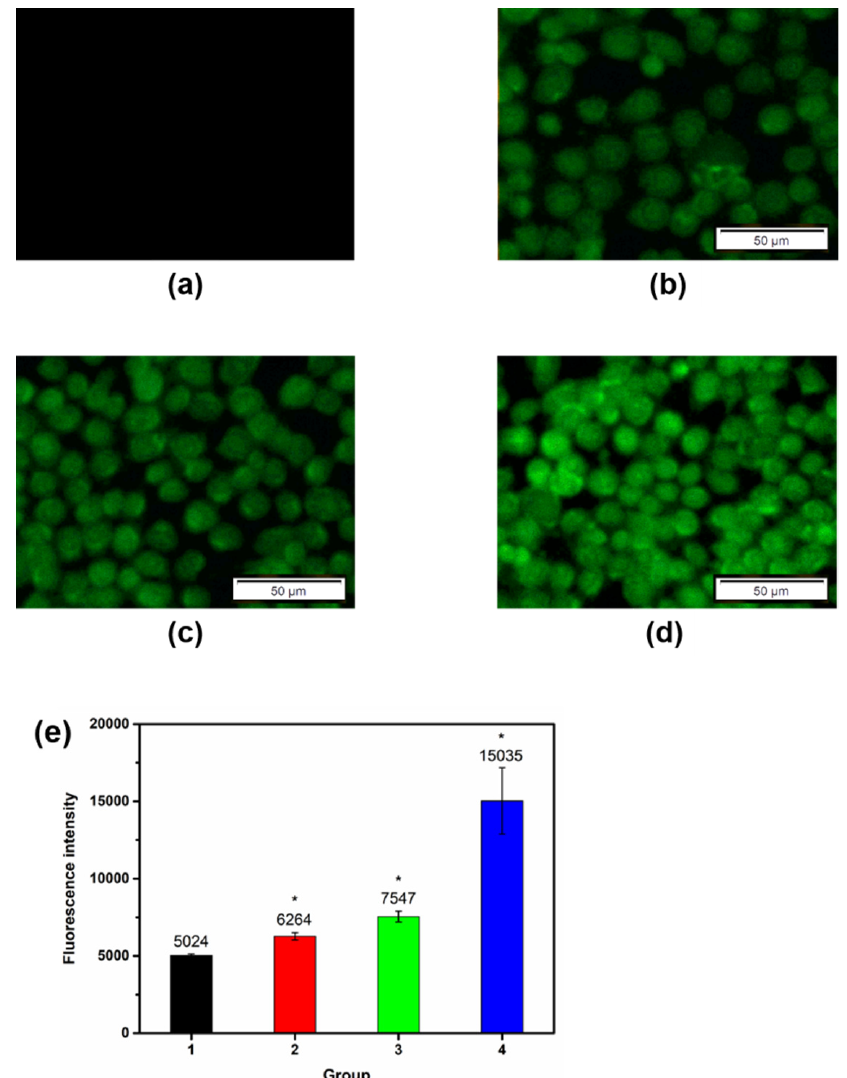
Figure 5. Detection of ROS using DCFDA assay on 4T1 cells for ( a ) control; ( b ) PA-AgNPs without Dox; ( c ) Dox-carried PA without AgNPs; ( d ) Dox-carried PA-AgNPs; and ( e ) fluorescence intensity of each group (Group 1: Control; Group 2: PA-AgNPs without Dox; Group 3: Dox-carried PA without AgNPs; Group 4: Dox-carried PA-AgNPs). (Data characterize the mean ± SD, n = 3, * p < 0.05, Student’s t